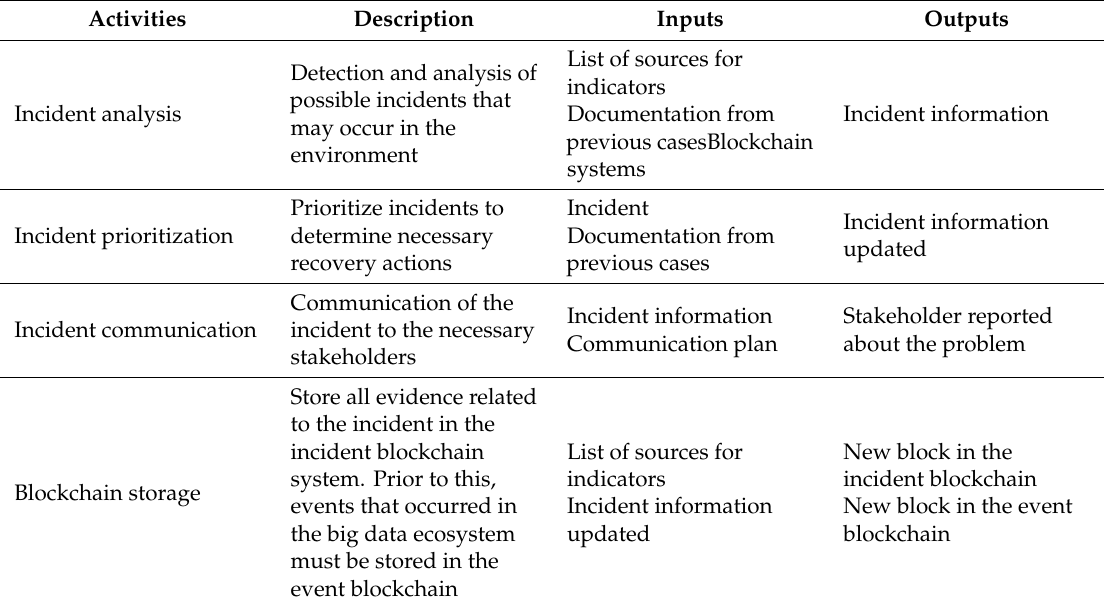
Table 5. Activities of Phase 3: identification and